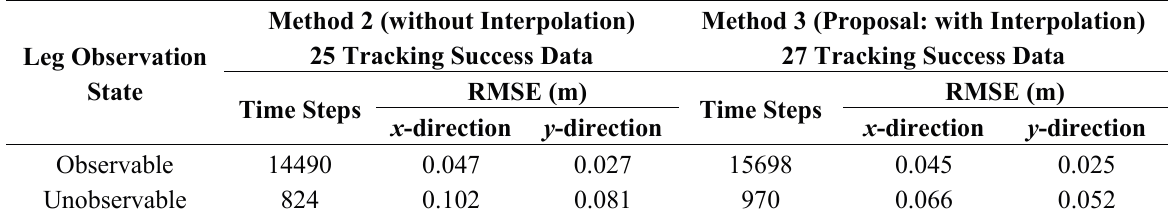
Table 5. RMSE of the leg trajectory in each leg observation state of the tracking success data of Methods 2 and